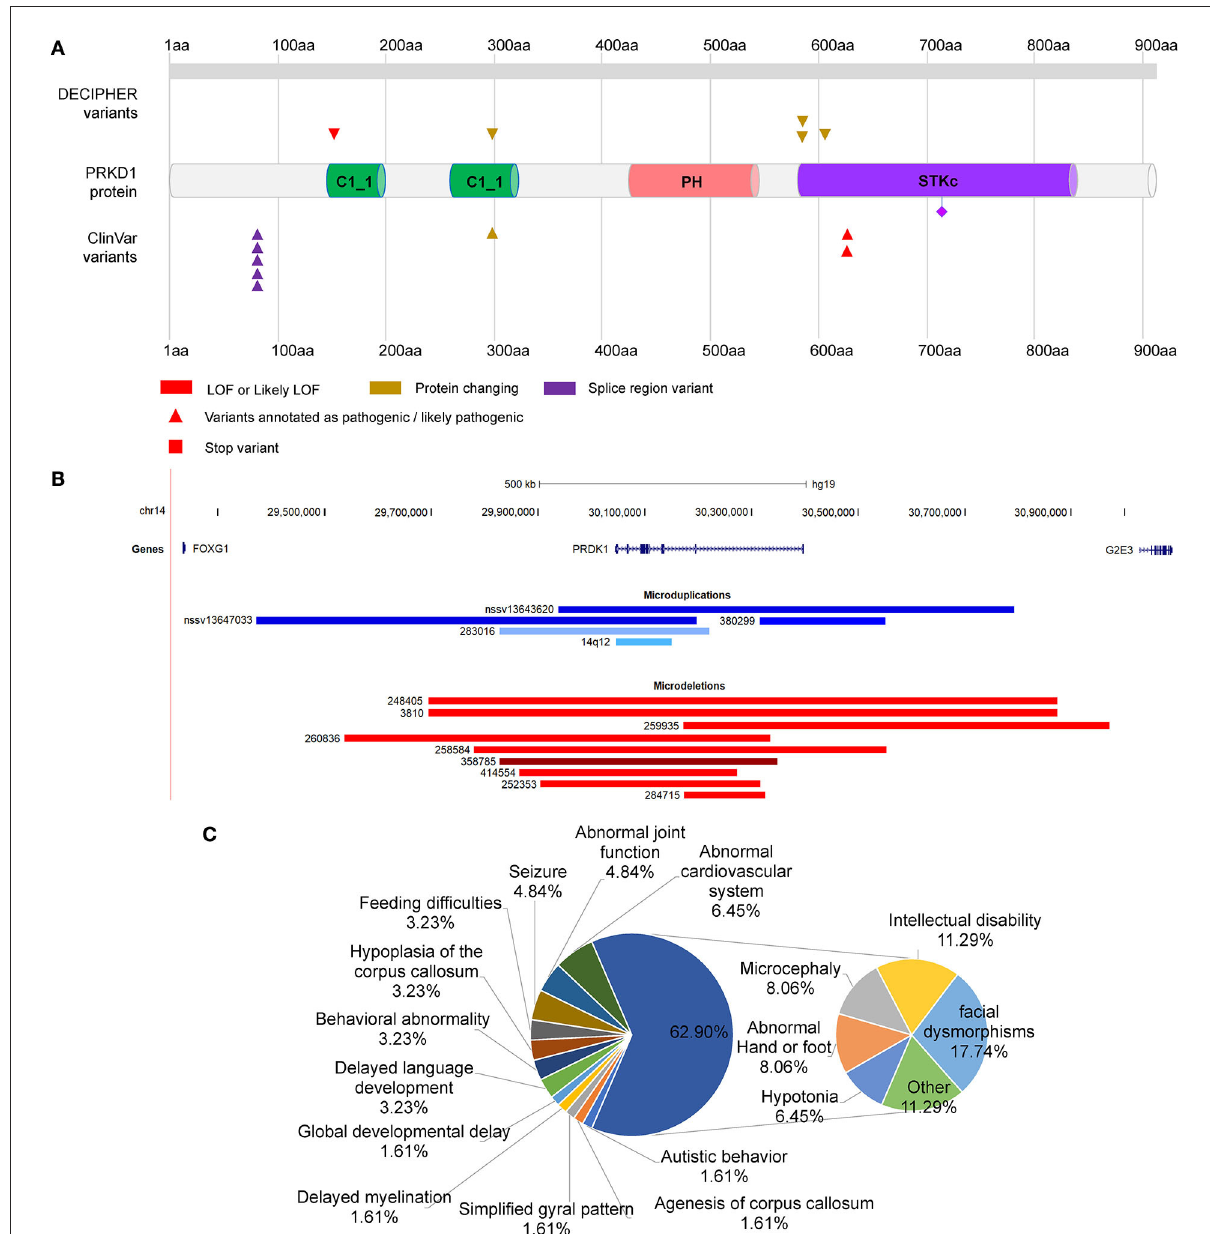
FIGURE5 Distribution of mutations in PRKD1. (A) Distribution of SNMs of PRKD1; (B) Copy number variations of PRKD1; (C) Ratios of clinical phenotypes in patients with CNVs containing